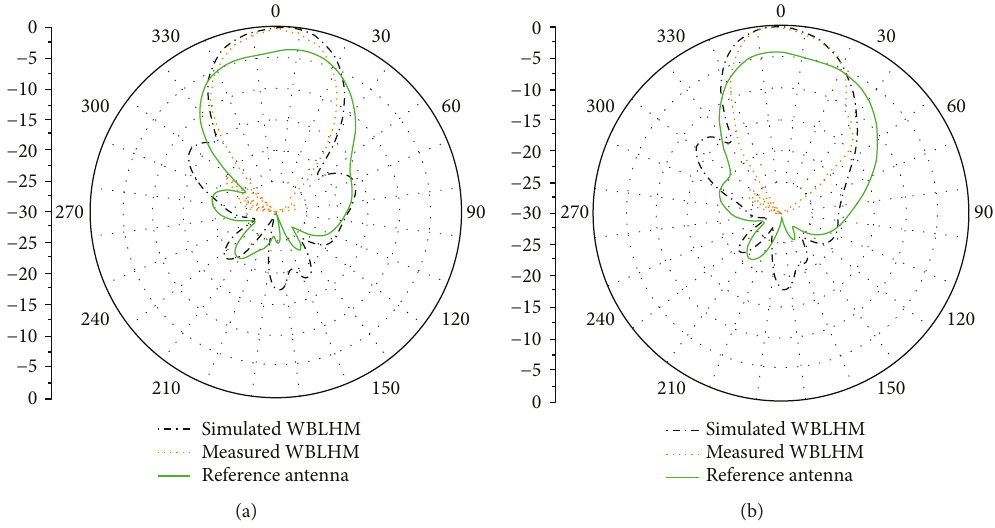
Figure 9: (a) Radiation pattern of reference antenna with and without WBLHM layer at 5.82Ghz: (E-plane). (b) Radiation pattern of reference antenna with and without WBLHM layer at 5.82Ghz